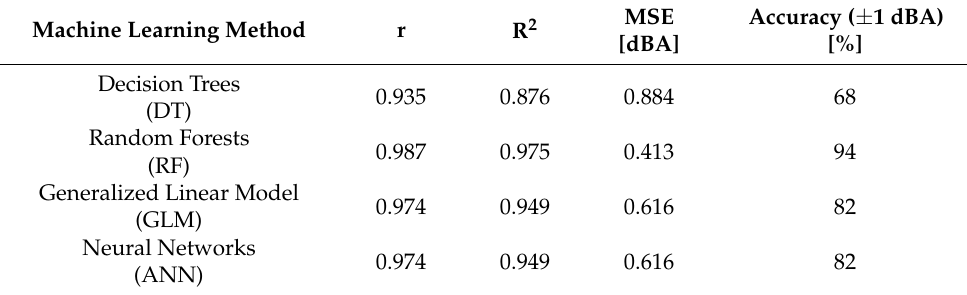
Table 3. Comparison of results for the prediction models in the training